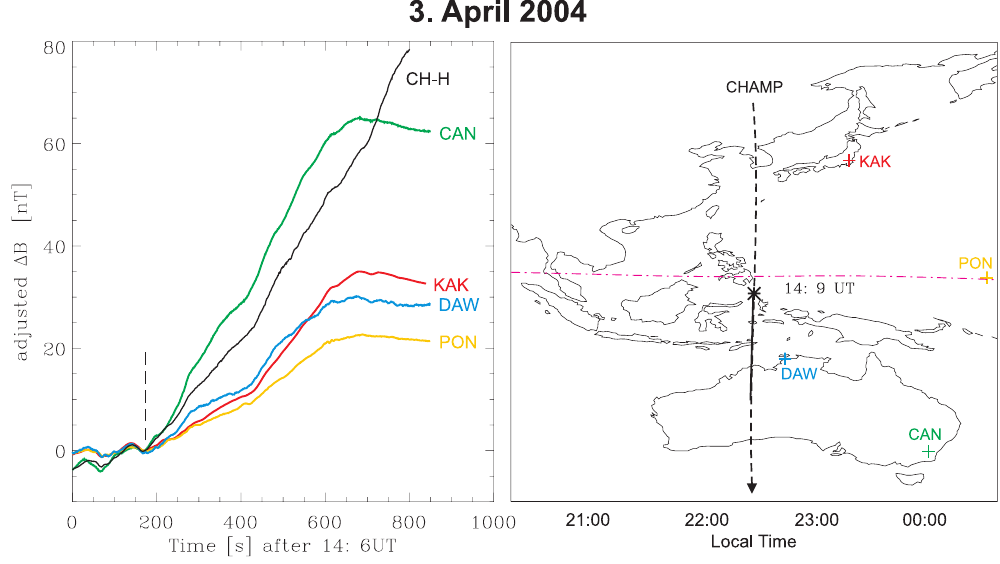
Fig. 5. Same as Fig. 2, but for the SC event on 3 April 2004, when CHAMP flew over